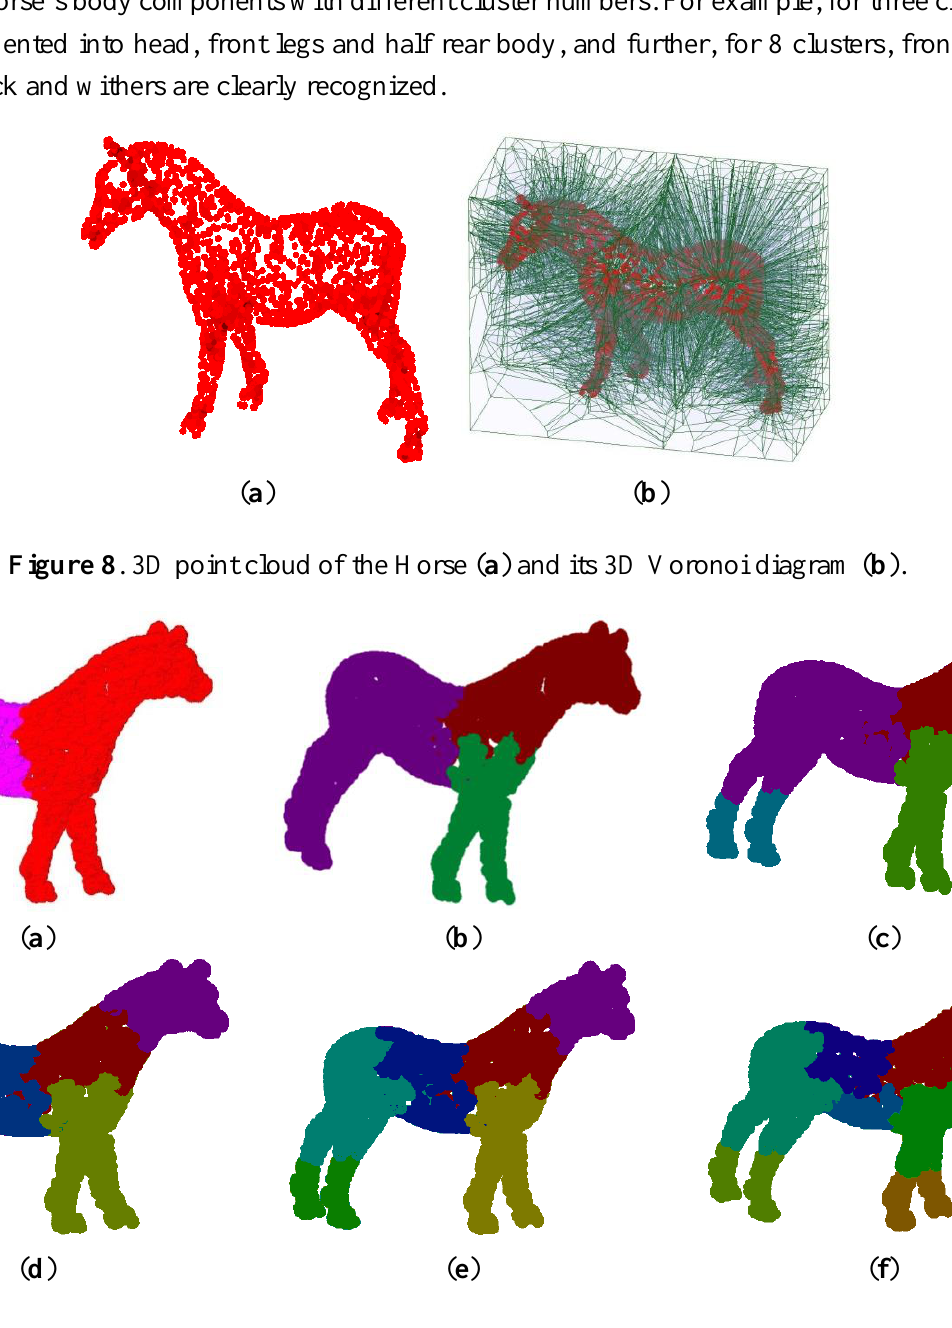
Figure 9 . Illustrations of clustering and segmentation of the Horse point cloud with different cluster numbers: ( a ) 2; ( b ) 3; ( c ) 4; ( d ) 5; ( e ) 6 and ( f )